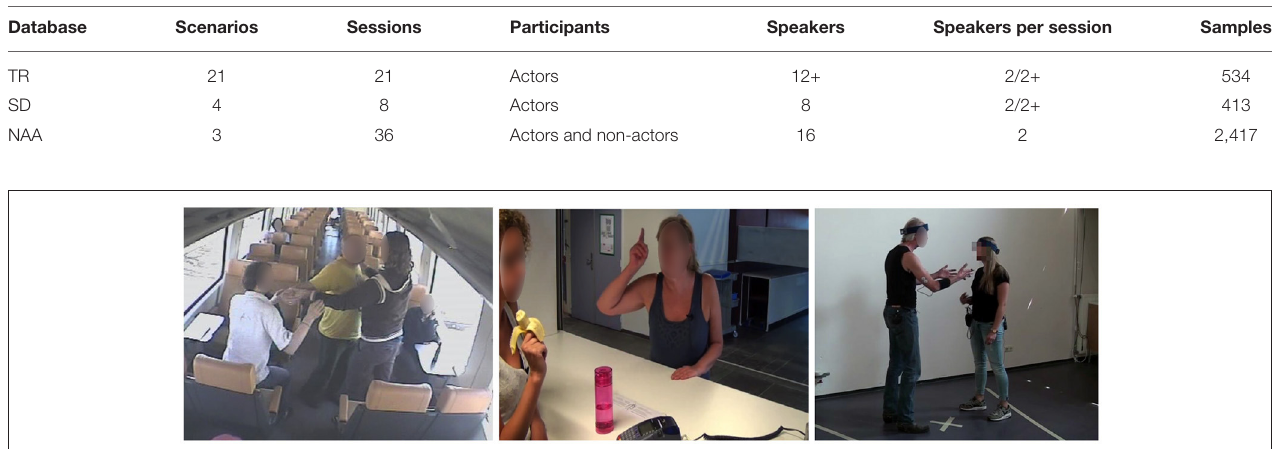
TABLE 1 | Description of the considered datasets in terms of numbers of scenarios, total played sessions, type and number of speaker in total and interacting per session, and total samples. Database